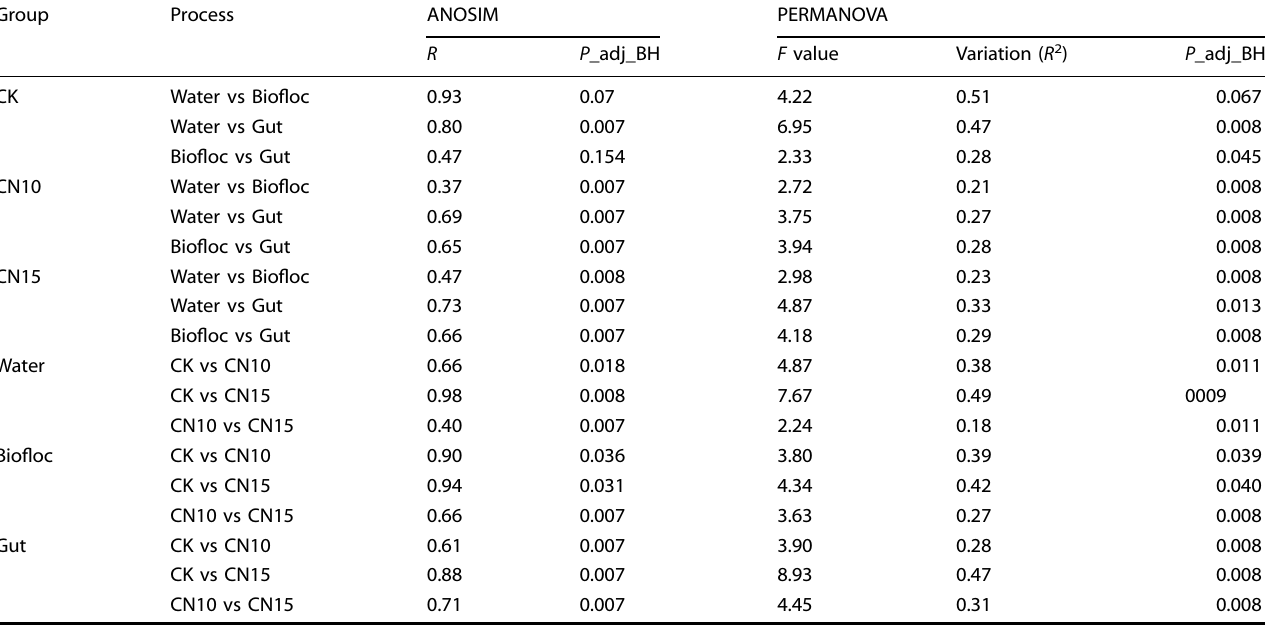
Table 1. ANOSIM and PERMANOVA analysis between different groups.